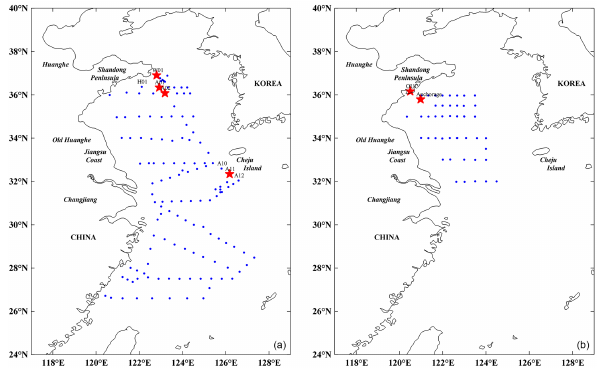
Figure 1. Cruise track during China Sea (a) cruise during 16 October–5 November in 2011 and (b) cruise during 2–11 November in 2012. Pentacles represent the locations of particle burst